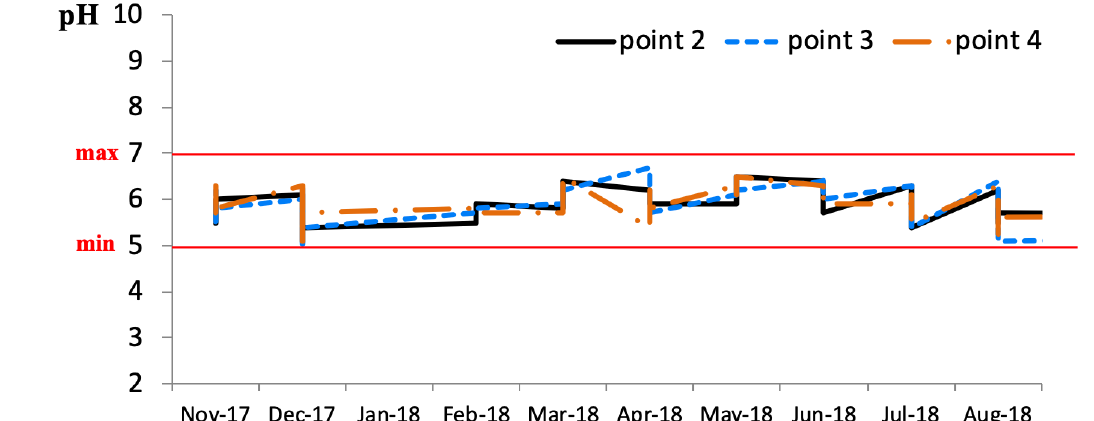
FIGURE 3 - pH Monitoring at sampling points after the application of corrective actions 60x30mm (300 x 300